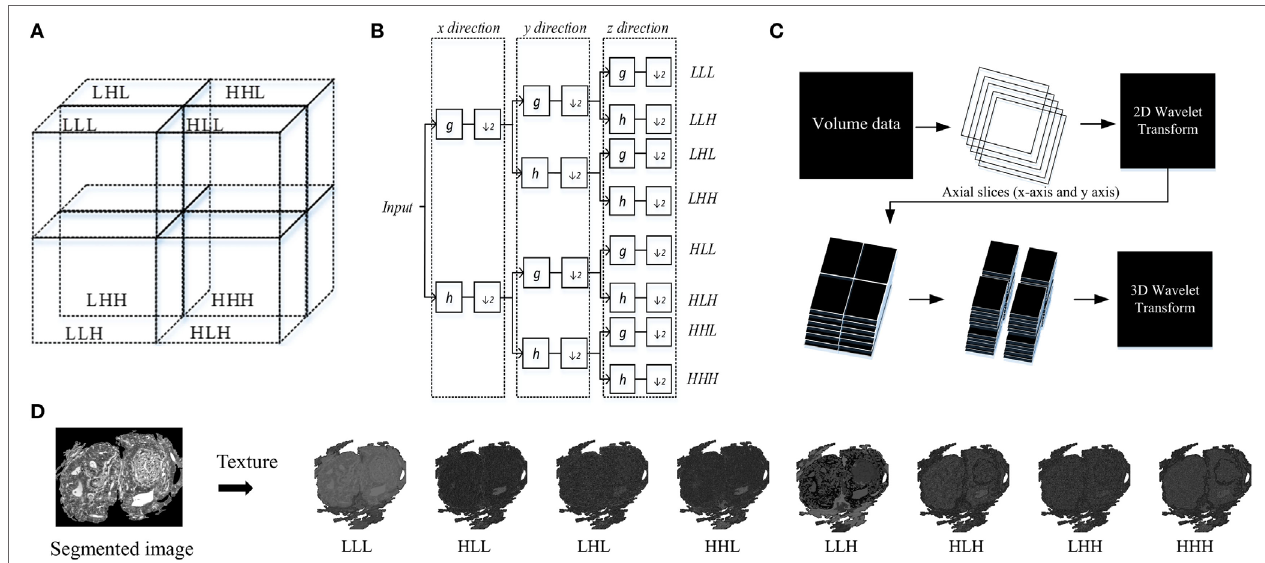
FigUre 4 | Structure of 3D wavelet decomposition and its corresponding filter bank. (a) Schema of sub-band partition of a single level decomposition, (B) block diagram of a filter bank for a single level decomposition, (c) 3D wavelet transform (3D-WT) scheme based on 2D + 1D model. (D) Schema of texture based 3D-WT, an example of carcinoma scheme sample of the eight oct-bands (in this study called multiscale texture) using